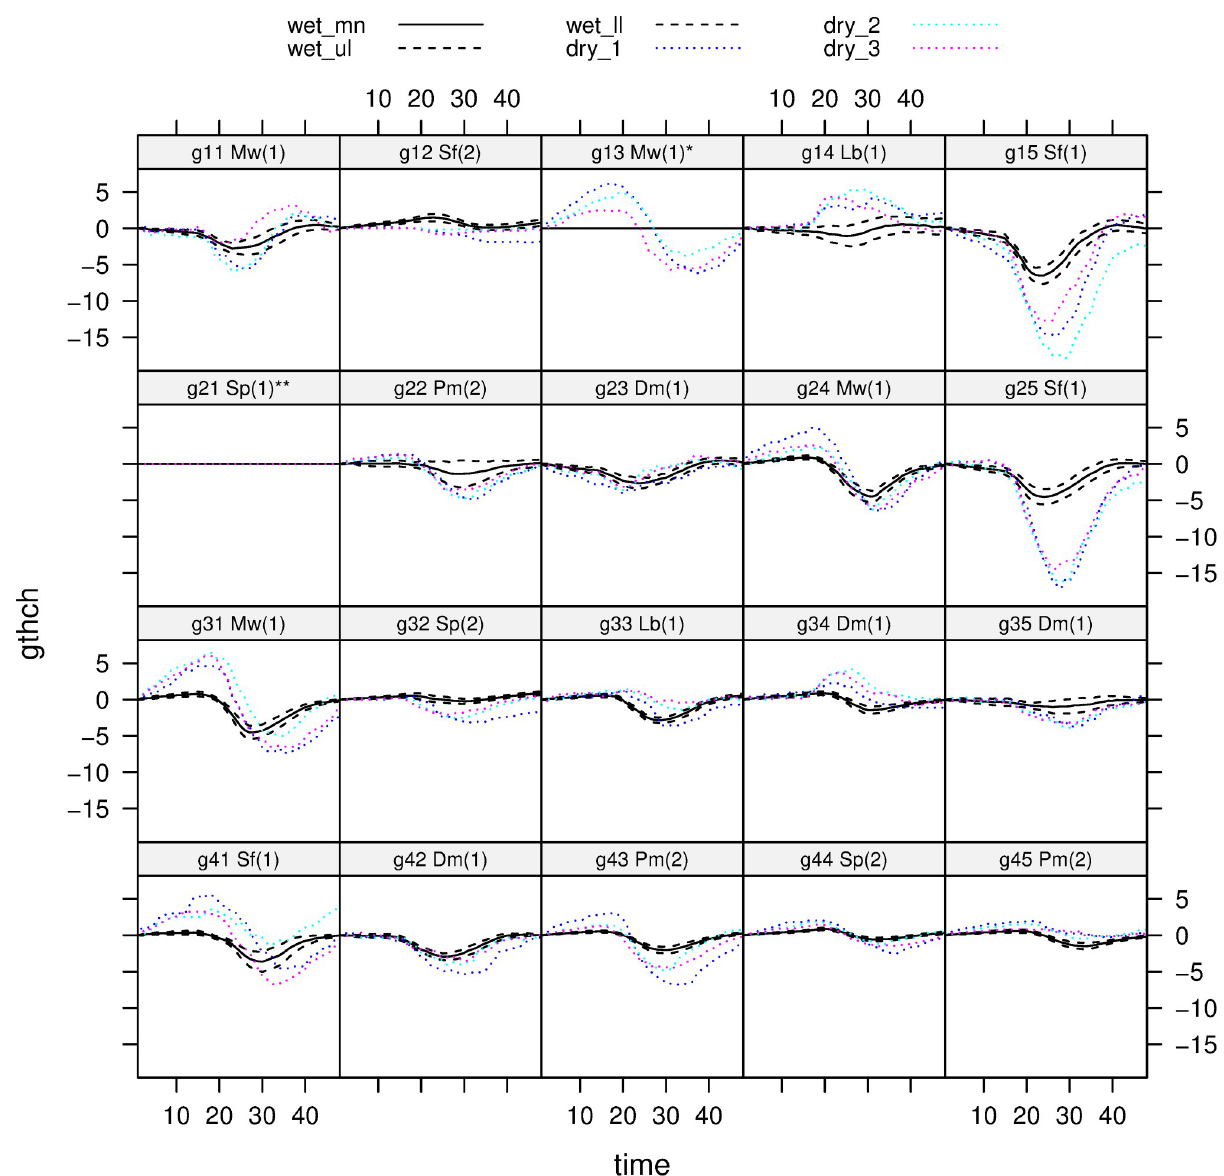
Fig 3. Mean diurnal change in tree girth ( gthch ) for each of the selected trees. Values were integrated for 48 half-hour time intervals referenced daily to 00:00, and expressed per mille. Two trees’ series (see Fig 1) were insufficient and were later omitted. Panel headers: following the band codes are species codes and, in parenthesis, tree size classes ( scl ), as listed in Table 2. The solid black curves are the means of the thirty 18-day sub-periods of the wet period and the black dashed lines their 95% confidence limits. The dotted colored curves are the three sub-periods of the dry period. Positive values of gthch indicate stem swelling, and negative ones, stem shrinkage. Each successive row of panels is for stations 1 to 4, each row with its four-five trees (see Table